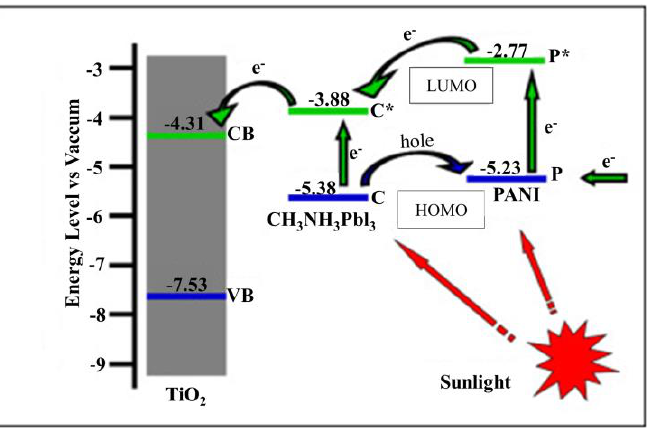
Figure 25. Schematic energy level illustration of TiO2, CH3NH3Pbl3, and PANI. Reproduced from Power Sources, 267, Xiao, Y.; Han, G.; Chang, Y.; Zhou, H.; Li, M.; Li, Y., An all-solid-state perovskite-sensitized solar cell based on the dual function polyaniline as the sensitizer and p-type hole-transporting material, pp. 1–8., Copyright (2014), with permission from Elsevier.